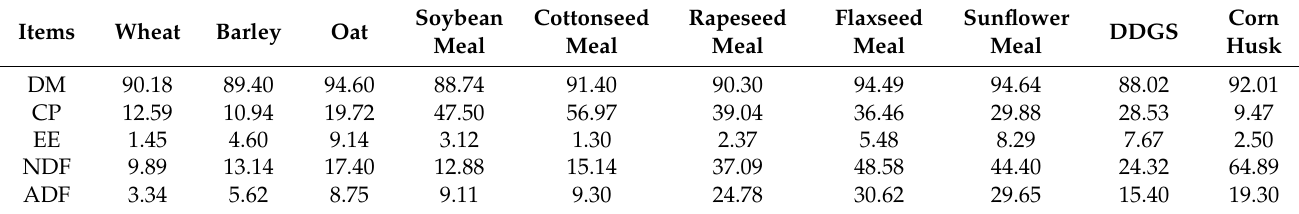
Table 1. Test the concentrate organic nutrients levels (%, dry